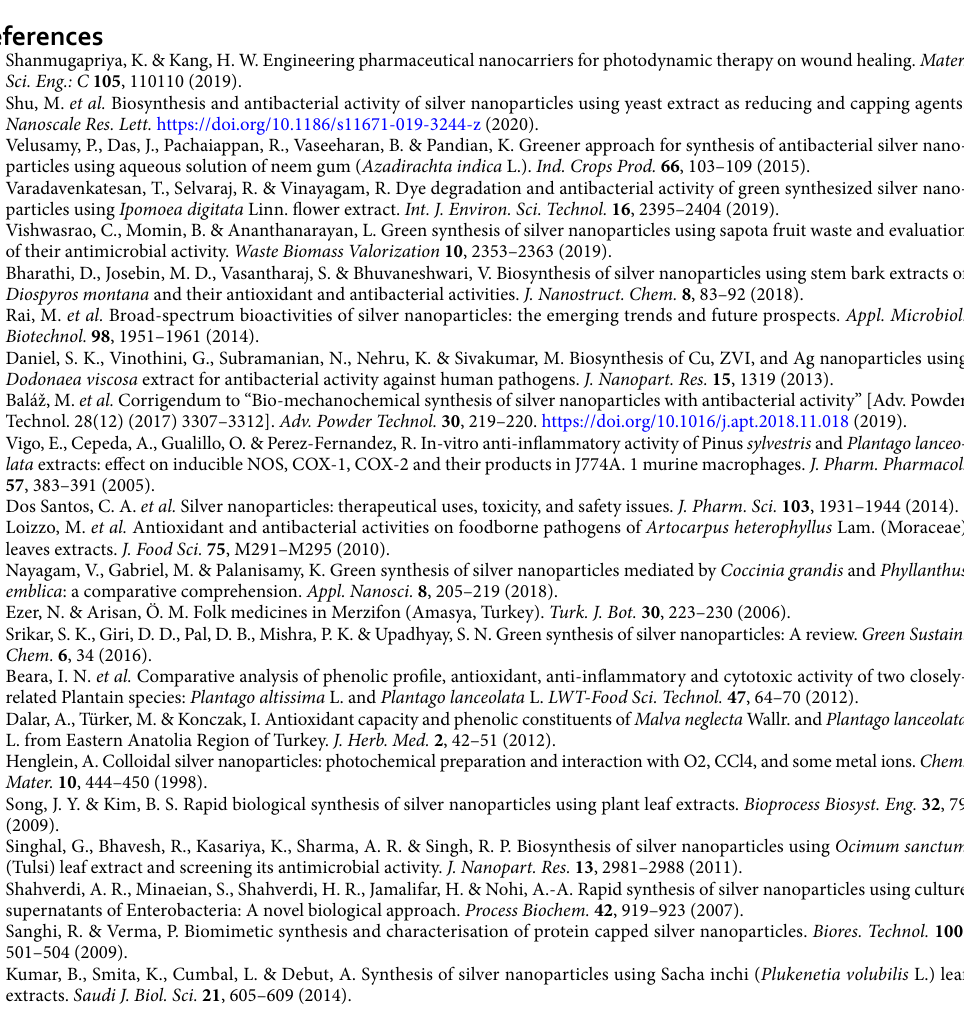
16.85 ± 0.4 at 100 μg L −1 , respectively, showing an increase with high concentration. Finally, P. lanceolata extract and its Ag. NPs might be the best option for therapeutic and medical applications.